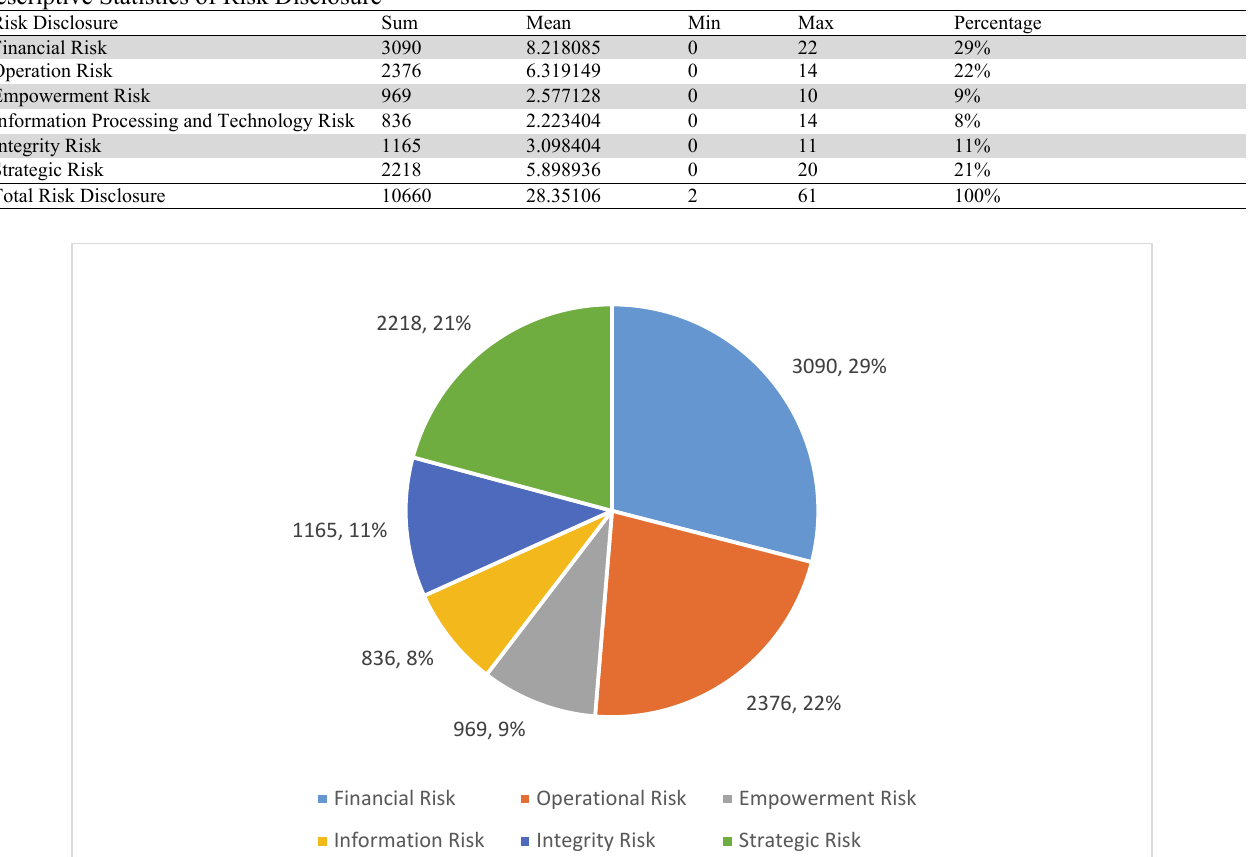
Fig. 1. Number of Risk Disclosure Sentences for Each Category of